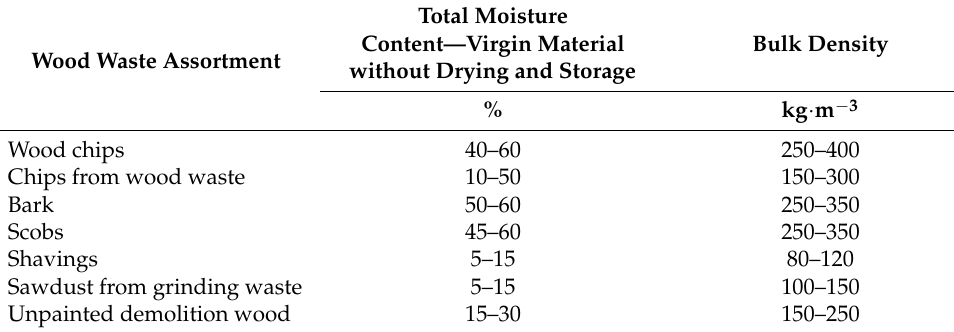
Table 4. Total moisture content and bulk density of wood waste